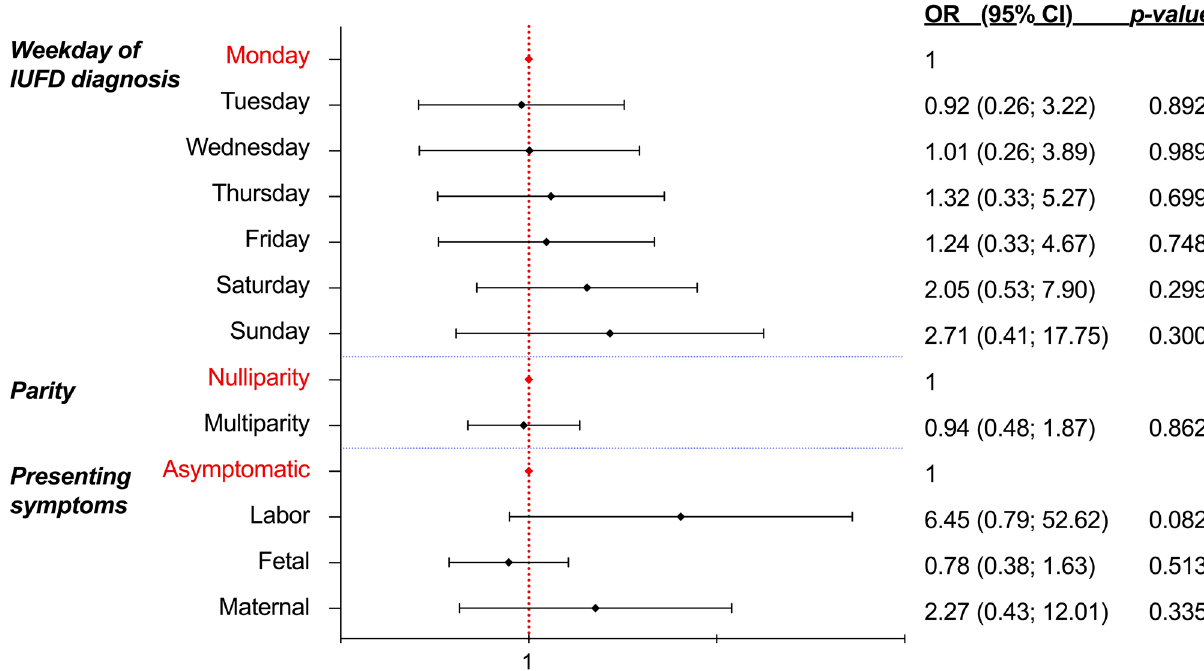
Figure 2. Forest plot illustrating the odds ratios (and 95% Confidence Intervals) from multivariate logistic regression to identify the relationship between timing of hospital admission and possible predictors (i.e., weekday, parity, presenting symptom at diagnosis) following intrauterine fetal death (n = 183; level of significance p < 0.05, two-tailed). IUFD intrauterine fetal death, OR odds ratio, CI confidence interval. Figure software: Prism 9 for macOS, Version 9.2.0.